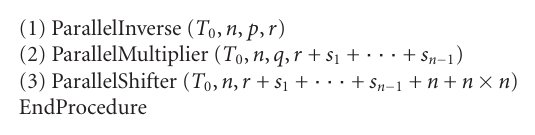
Algorithm 6: Procedure ParallelDivision ( T 0 , n , p , q , r